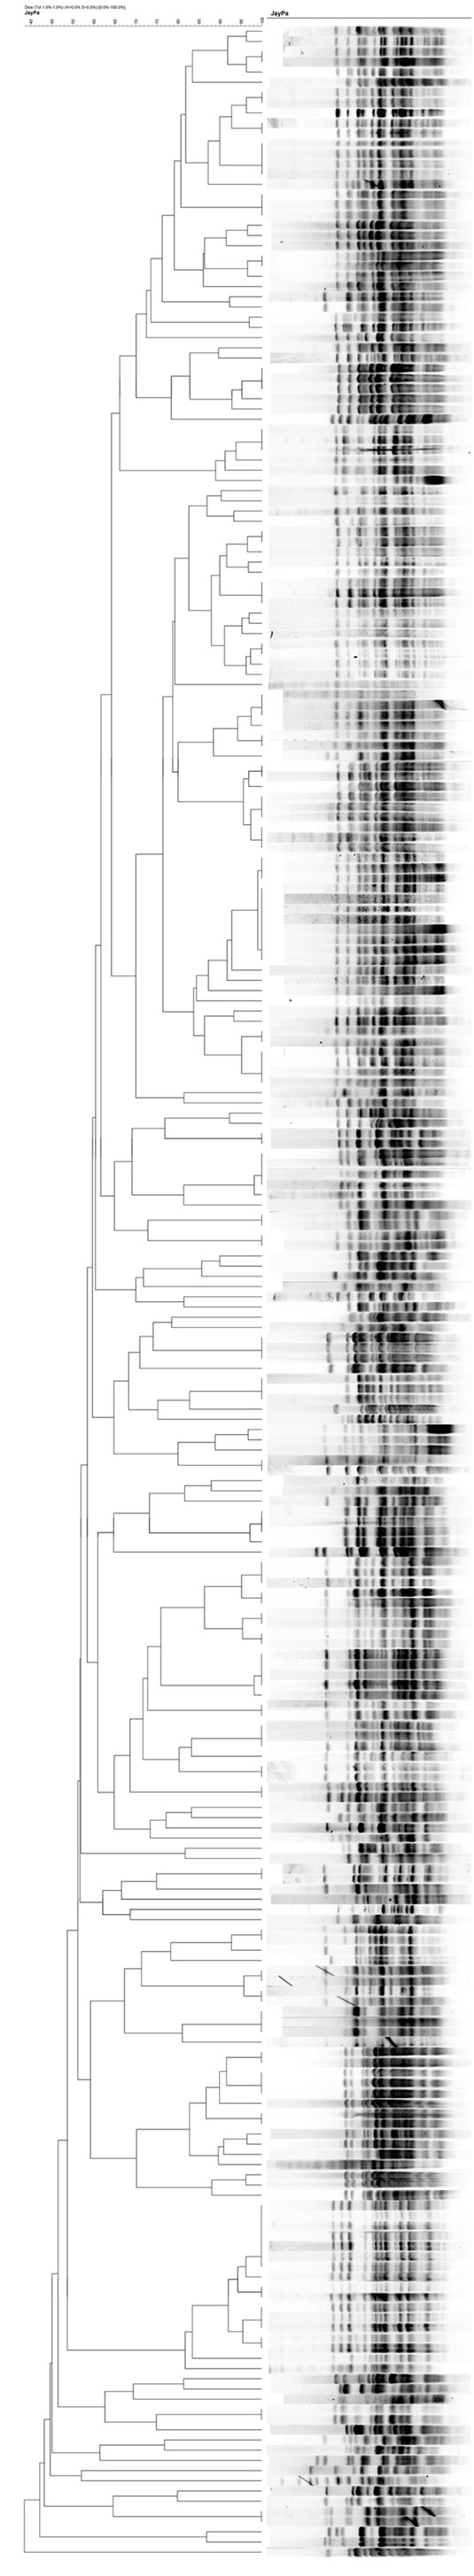
 A fingerprinting map showing the percentage of similarity among 187 strains of CR-MDR P. aeruginosa.